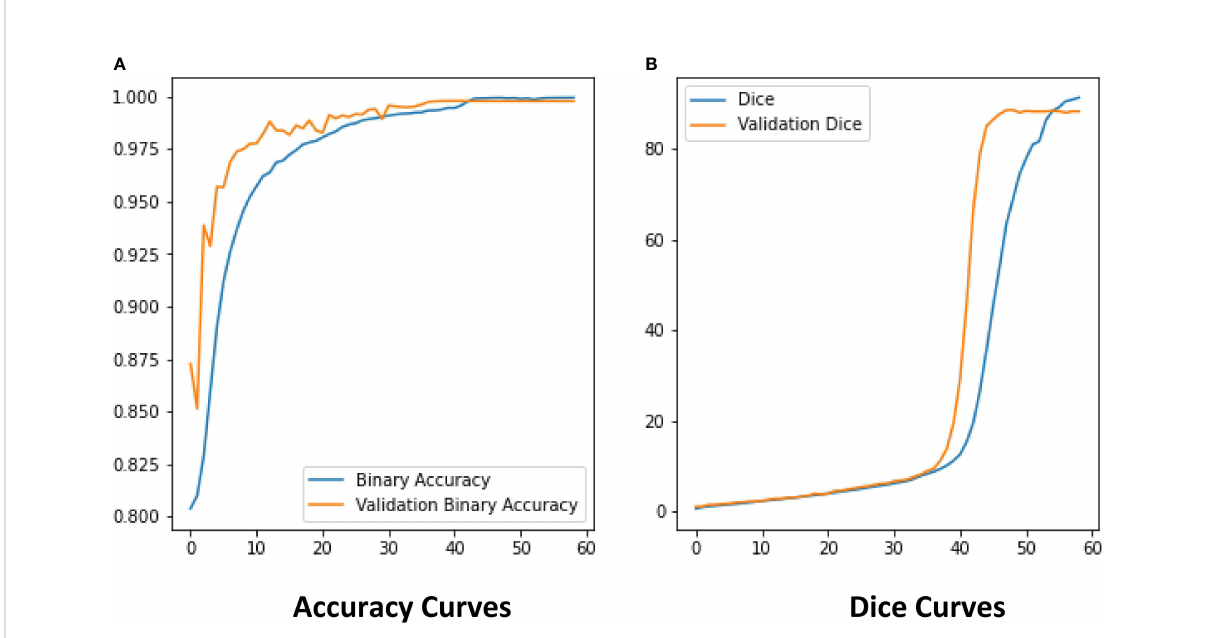
FIGURE 9 The Dice and Binary Accuracy of ROI model. (A) Accuracy Curves, (B) Dice